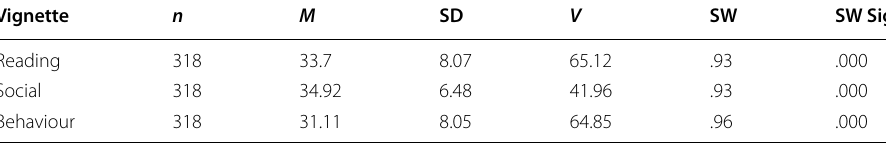
n represents sample size, M is mean, SD is standard deviation, V is Variance, SW is Shapiro–Wilk statistic, and SW Sig. is SW is Shapiro–Wilk significance